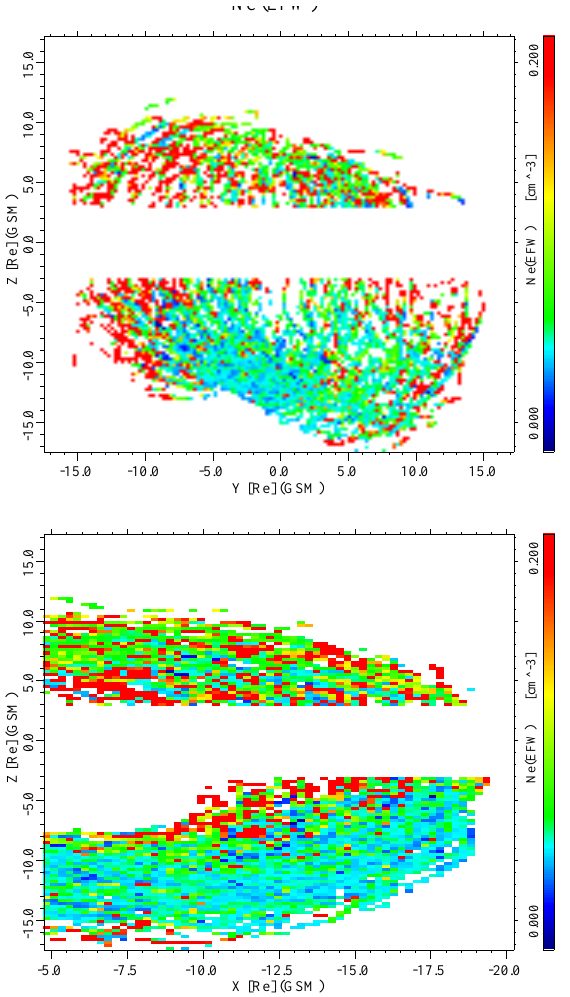
Fig. 2. This figure shows a color coded representation of the en- tire data space. In the top part the view is from the sun into the ZY-plane, and the bottom view is from the evening side into the ZX-plane. In each of these two plots the measurements are col- lapsed into two planes with every square representing the most likely density measurement along the axis perpendicular to the par- ticular